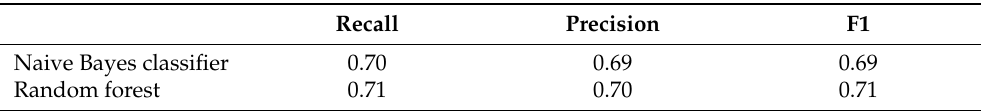
Table 10. Results of identifying CS and NCS by inputting the characteristics of the left foot for machine